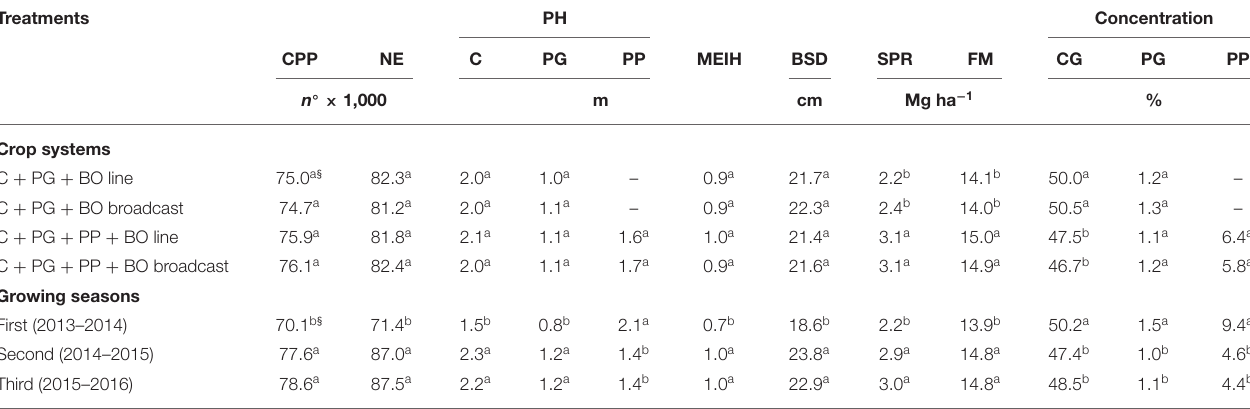
TABLE 4 | Corn plant population (CPP), number of ears per hectare (NE), plant height (PH), main ear insertion height (MEIH), basal stalk diameter (BSD), standing plant residue (SPR), forage mass (FM), and proportions of corn grains (CG), palisade grass and pigeon pea in corn to silage intercropped with palisade grass (C + PG) and with palisade grass and pigeon pea (C + PG + PP) with black oat (BO) oversown in lines and broadcast in three growing seasons.